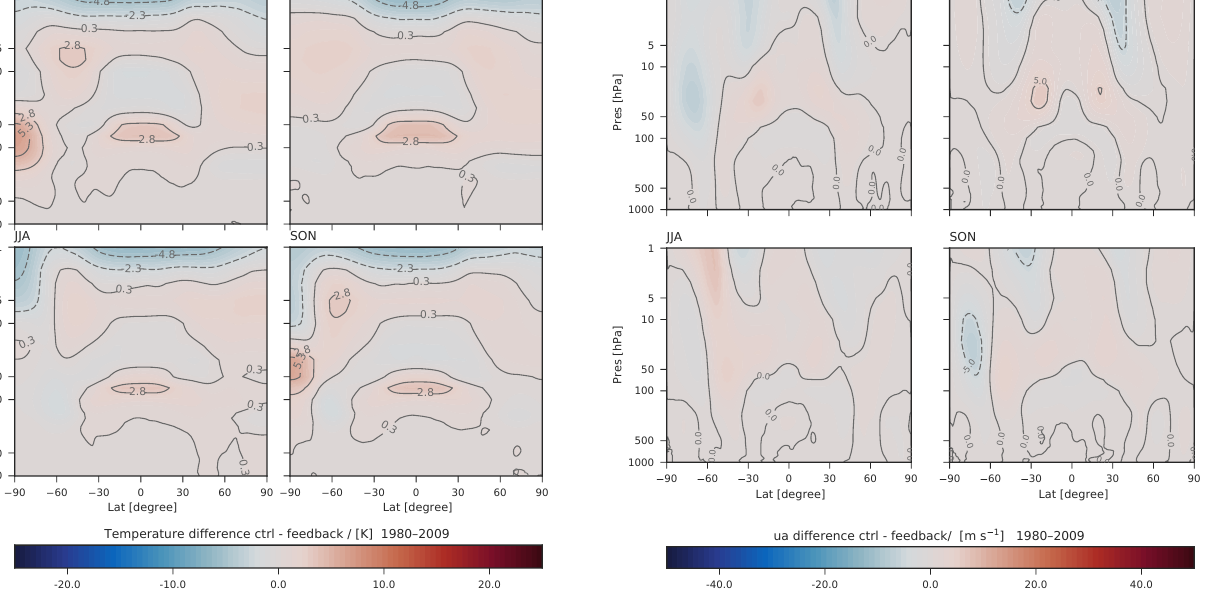
Figure B5. Latitude–height cross sections of seasonal and zonal mean zonal wind differences (ms − 1 ) for ICON-ART simulations from 1980 to 2009. (a) Control run; (b) feedback simulation.